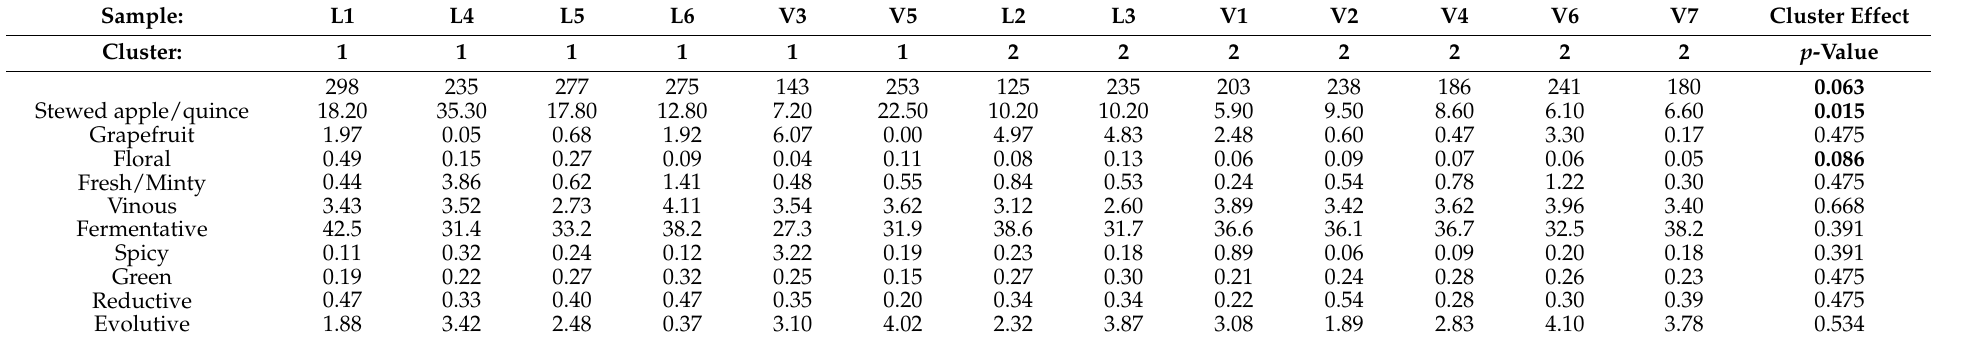
Table 5. Aromatic series values for each samples, and Mann-Whitney test between clusters. Significant values ( α = 0.1) are in